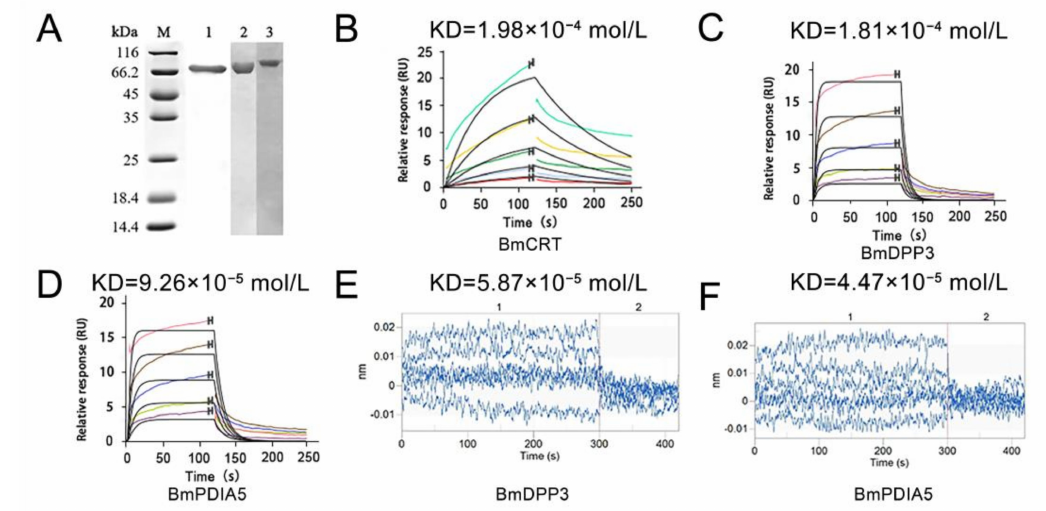
Figure 2. Binding affinity of DA with three proteins. ( A ) SDS-PAGE of three purified proteins. Lane M: Protein Marker; Lane 1: BmCRT; Lane 2: BmDPP3; Lane 3: BmPDIA5. ( B – D ) The ki- netic fitting curves for the interactions between BmCRT, BmDPP3, and BmPDIA5 and DA by SPR. The curves B to D show the molecular interaction curves between proteins and different DA concentrations (250 µ mol/L, 125 µ mol/L, 62.5 µ mol/L, 31.25 µ mol/L, 15.62 µ mol/L) from top to bottom. ( E , F ) The Align X for the interactions between BmDPP3, BmPDIA5, and DA by BLI. 1 and 2 show the processes of association and dissociation between proteins and DA.